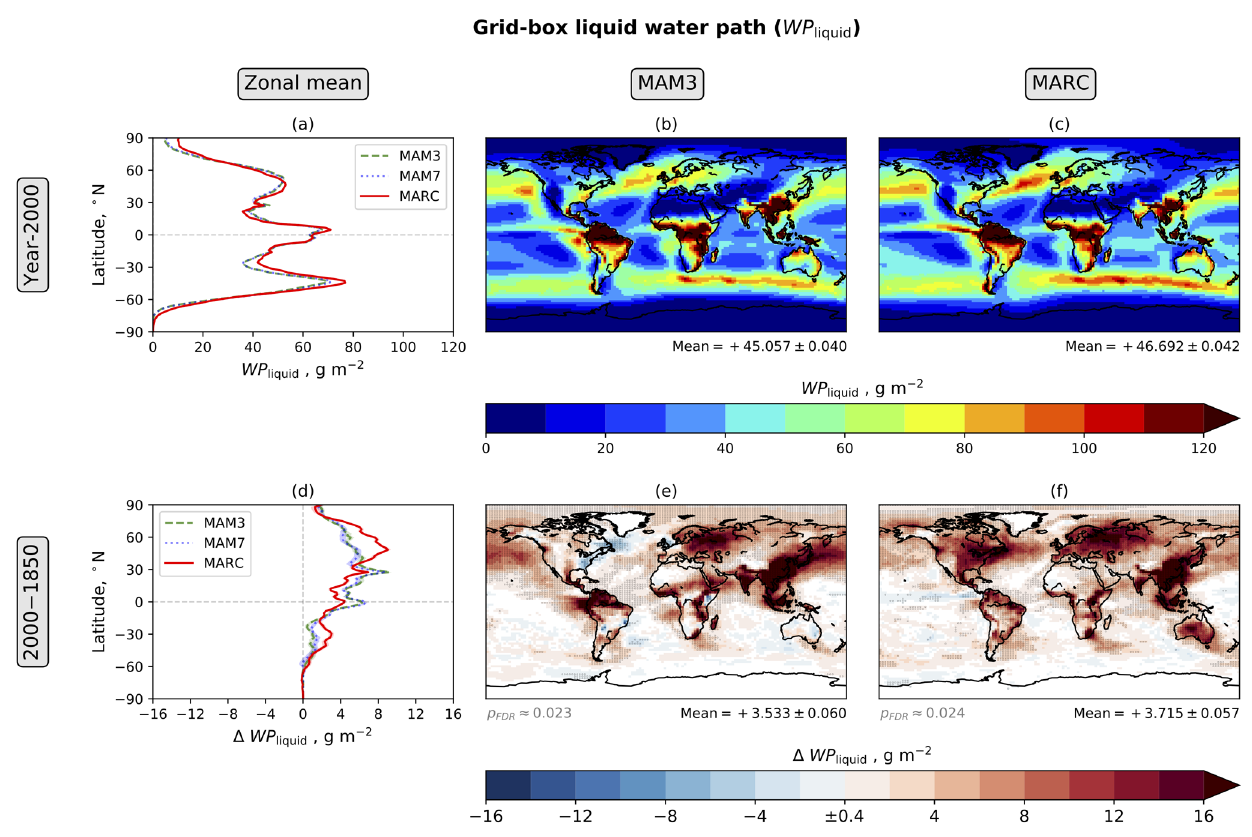
Figure 12. Annual mean grid-box cloud liquid water path (WP liquid ). The figure components are explained in the Fig. 2